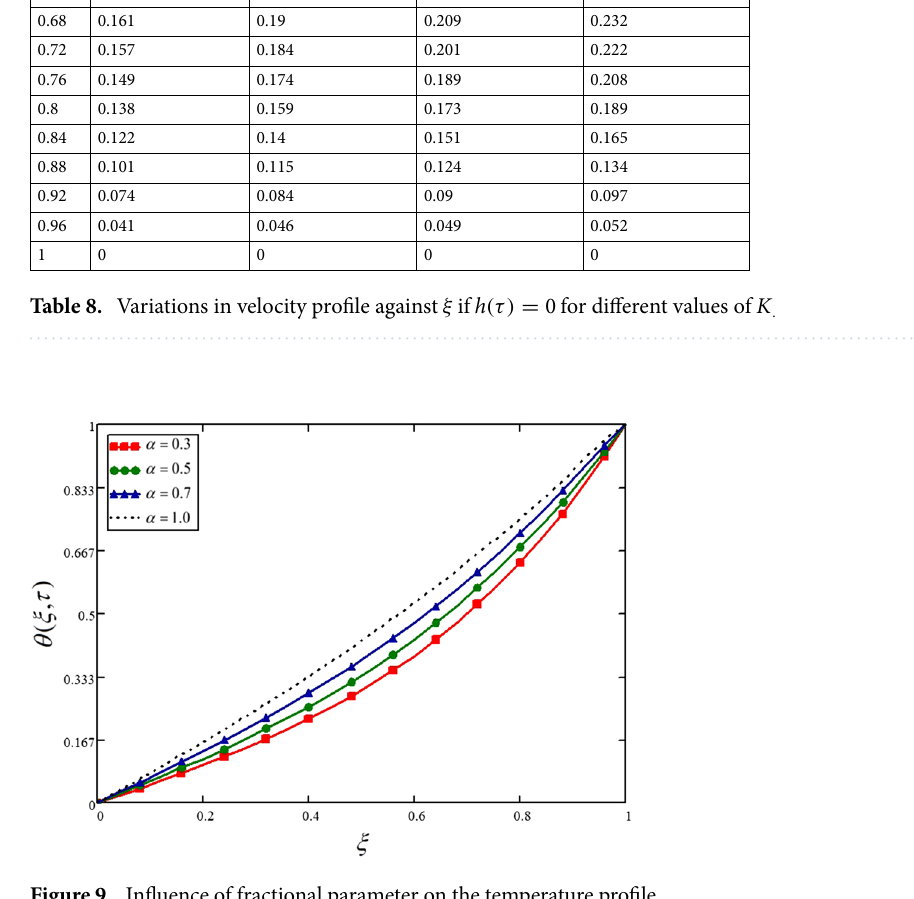
Figure 9. Influence of fractional parameter on the temperature